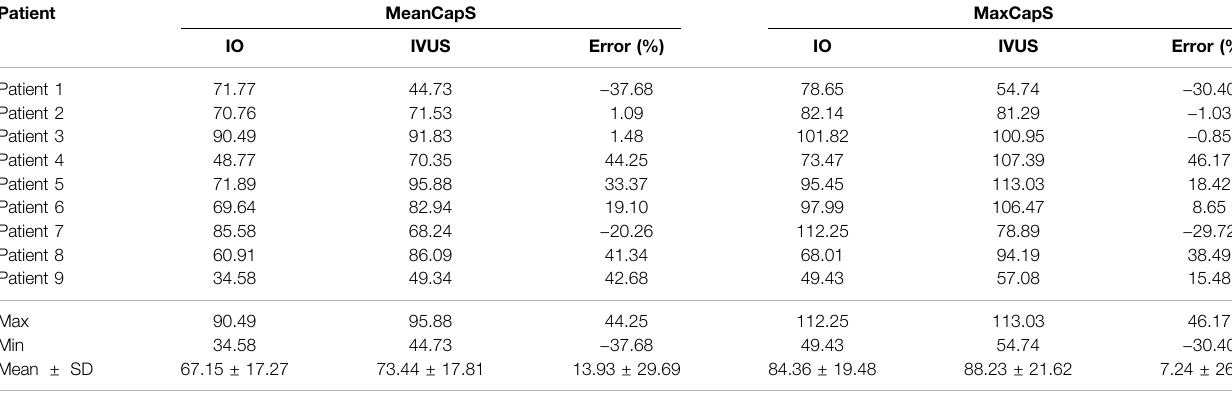
TABLE 3 | Summary of mean and maximum cap stress values for the plaques of 9 patients. Unit for stress: kPa. Patient